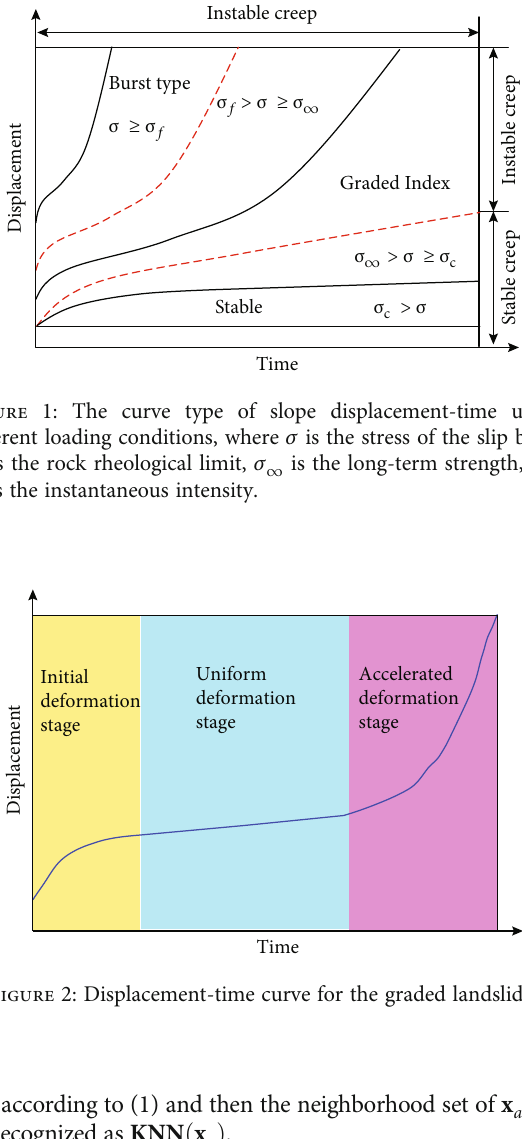
Figure 2: Displacement-time curve for the graded